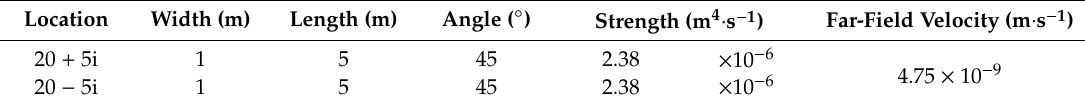
Table A3. Attributes of idealized synthetic flow channels (Case A).